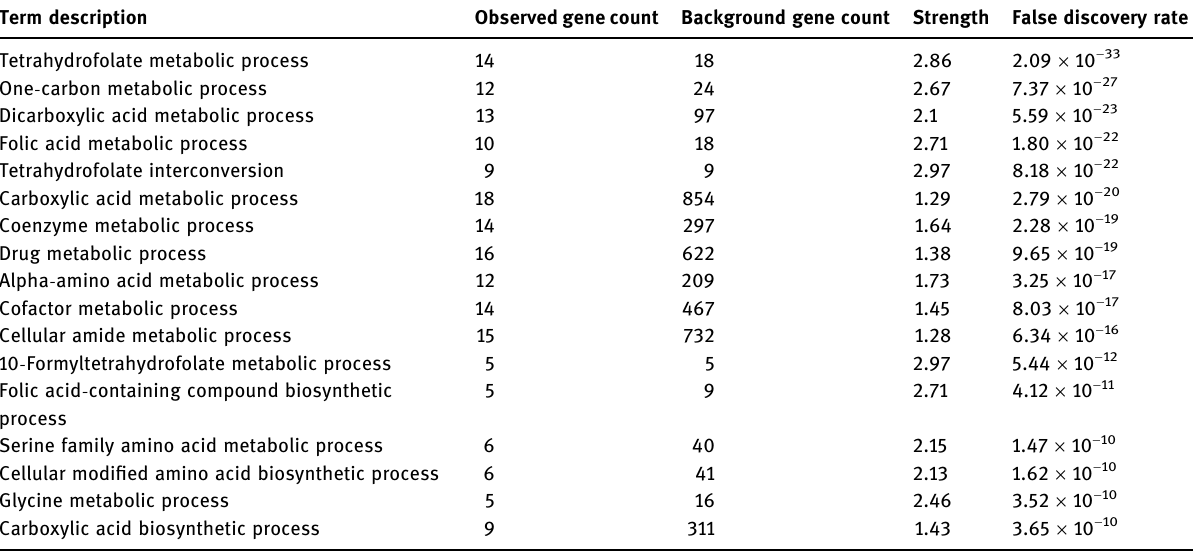
Term description